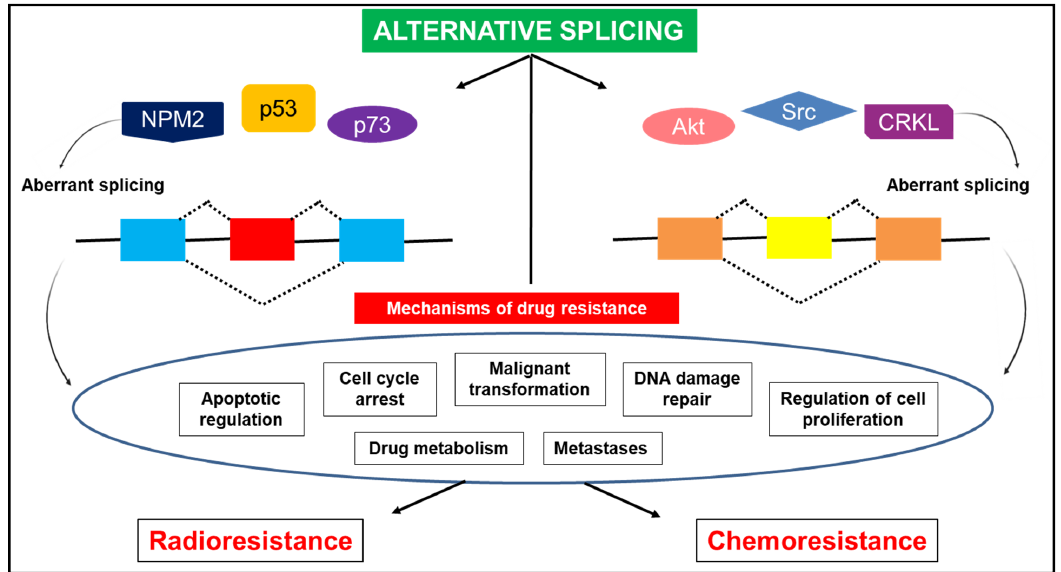
Figure 6. Alternative splicing-induced drug resistance. Aberrant splicing events of vital genes in cervical cancer cells promote drug resistance through several mechanisms by regulating apoptosis, cell cycle arrest, cell proliferation, and DNA damage response. In addition, splice variants may also alter drug targets that effect drug metabolism and lead to chemoresistance and alter the sensitivity to radiotherapy [86,87,89,95,97–99].